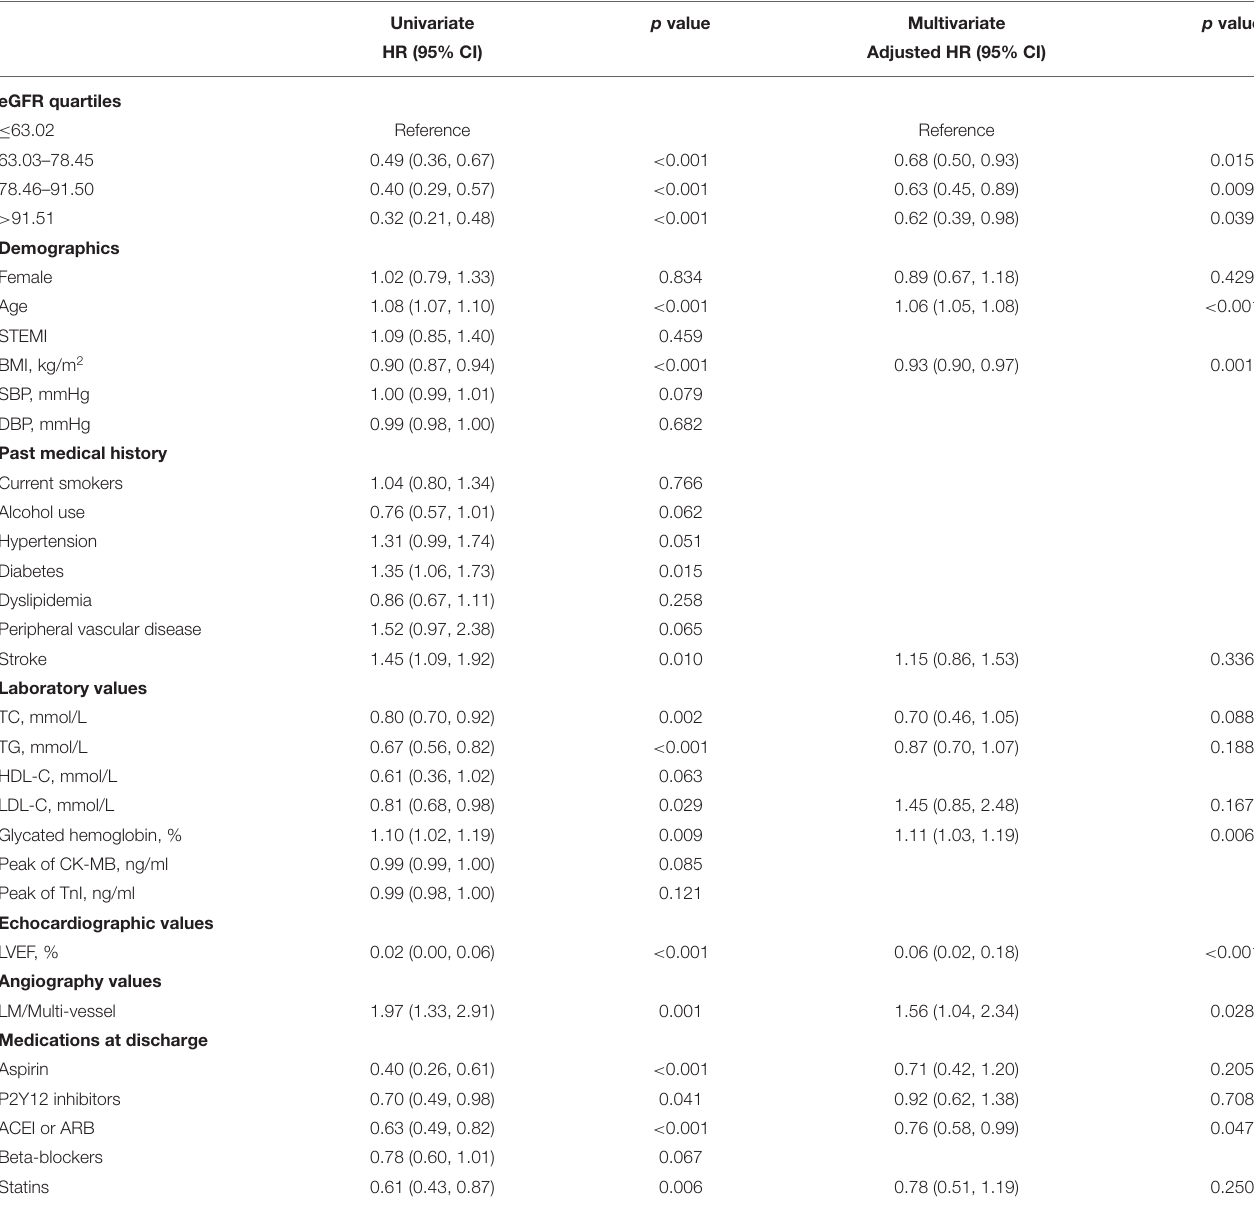
TABLE 3 | Independent predictors of all-cause death. Univariate p value